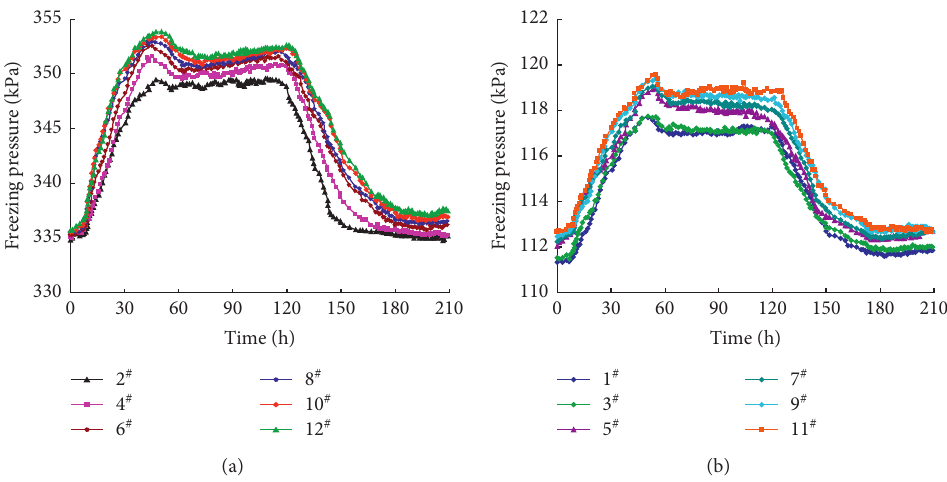
Figure 11: Low freezing pressure change. (a) Vertical freezing pressure. (b) Horizontal freezing pressure.